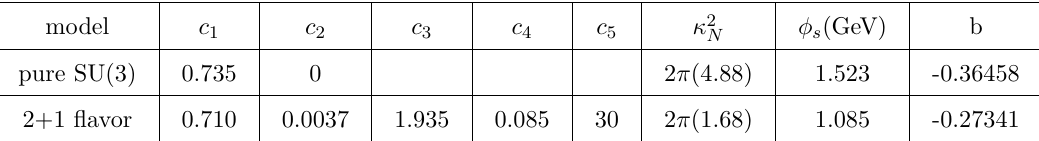
Table 1 . Parameters for the pure SU(3) gauge theory and 2 + 1 flavor models [54, 55] by matching the lattice